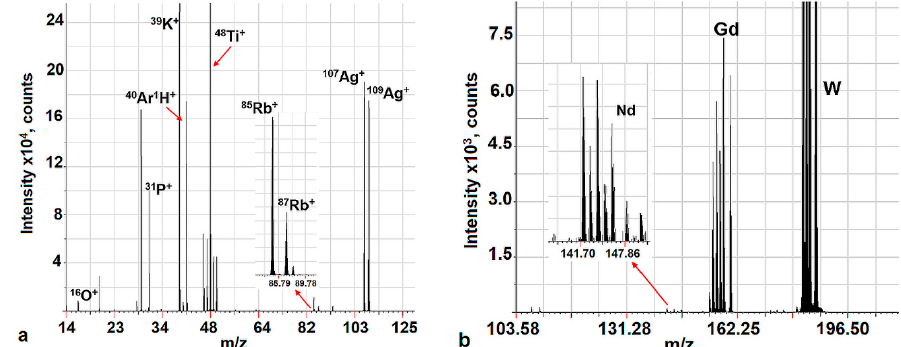
Figure 2. A mass spectrum range of K 0.95 Rb 0.05 TiOPO 4 ( a ) and KGd 0.95 Nd 0.05 (WO 4 ) 2 ( b ) crystals. Both mass spectra were acquired using optimal parameters. Both mass spectra were acquired using optimal